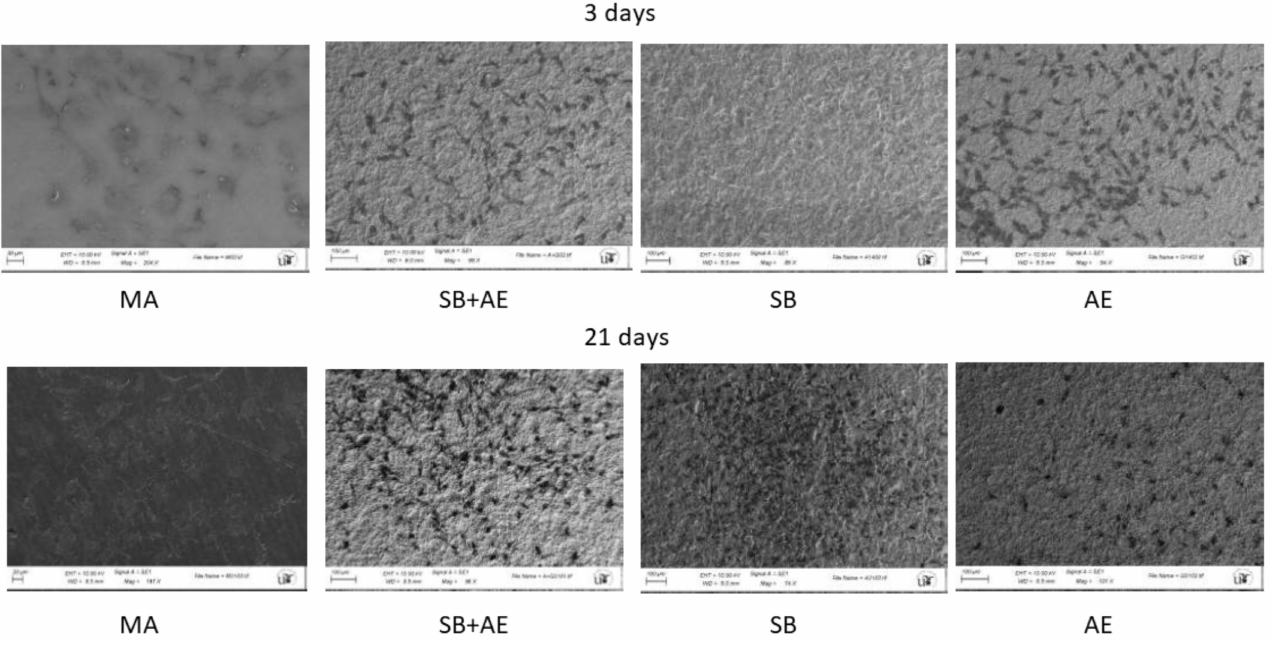
Figure 3. SaOS-2 osteoblastic cells observed by SEM at 3 and 21 days for the different topogra- phies